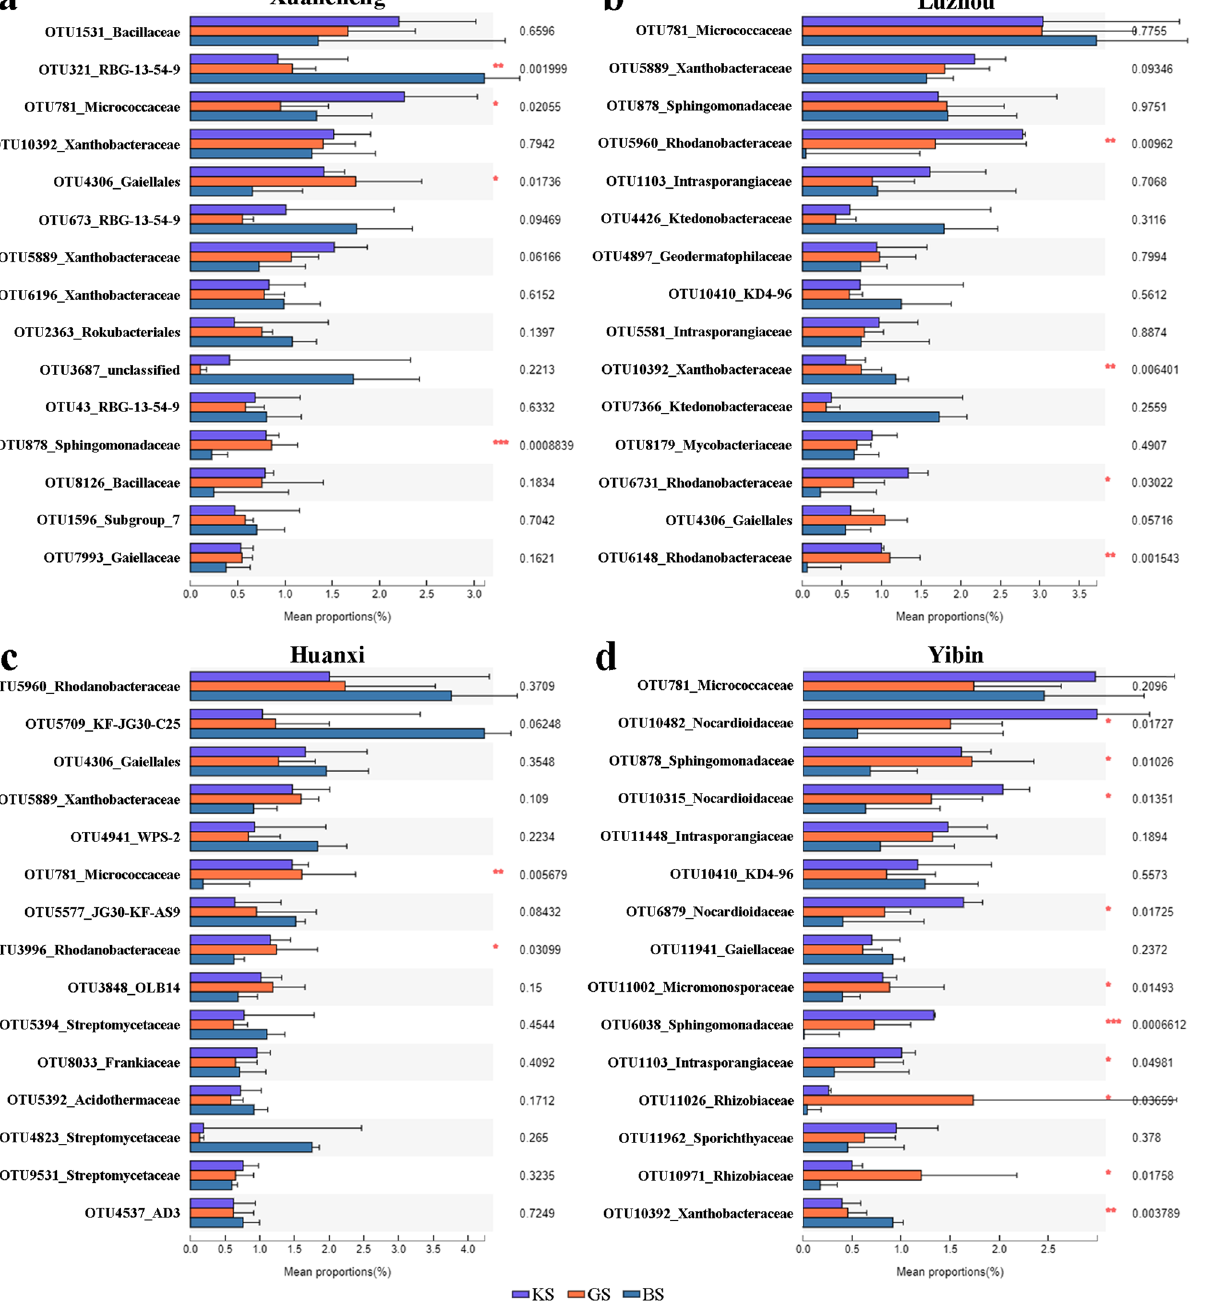
Figure 5. One-way ANOVA and FDR comparison analysis of microbial communities at the OTU level. ( a ) One-way ANOVA and FDR comparison analysis of microbial communities in Xuancheng. ( b ) One-way ANOVA and FDR comparison analysis of microbial communities in Luzhou. ( c ) One-way ANOVA and FDR comparison analysis of microbial communities in Huanxi. ( d) One-way ANOVA and FDR comparison analysis of microbial communities in Yibin. Data were analyzed by One-way ANOVA (*: 0.01 < p ≤ 0.05, **: 0.001 < p ≤ 0.01, ***: p ≤